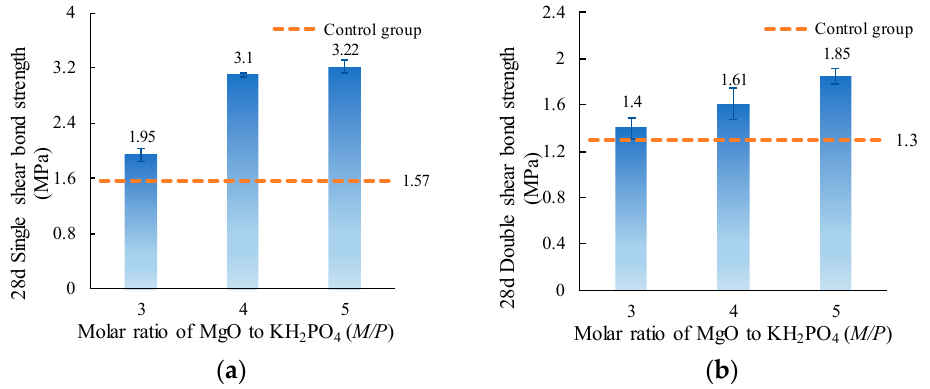
Figure 7. ( a ) Single shear bond strength and ( b ) double shear bond strength of specimens with varying M / P .